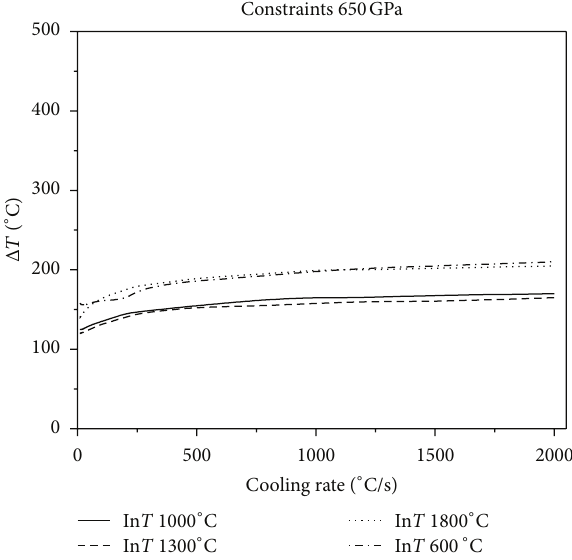
Figure 3: Relationship between critical fracture temperature Δ𝑇 corresponding to different thermal shock initial temperature and cooling rate which Young’s modulus of constraint material is 100GPa.